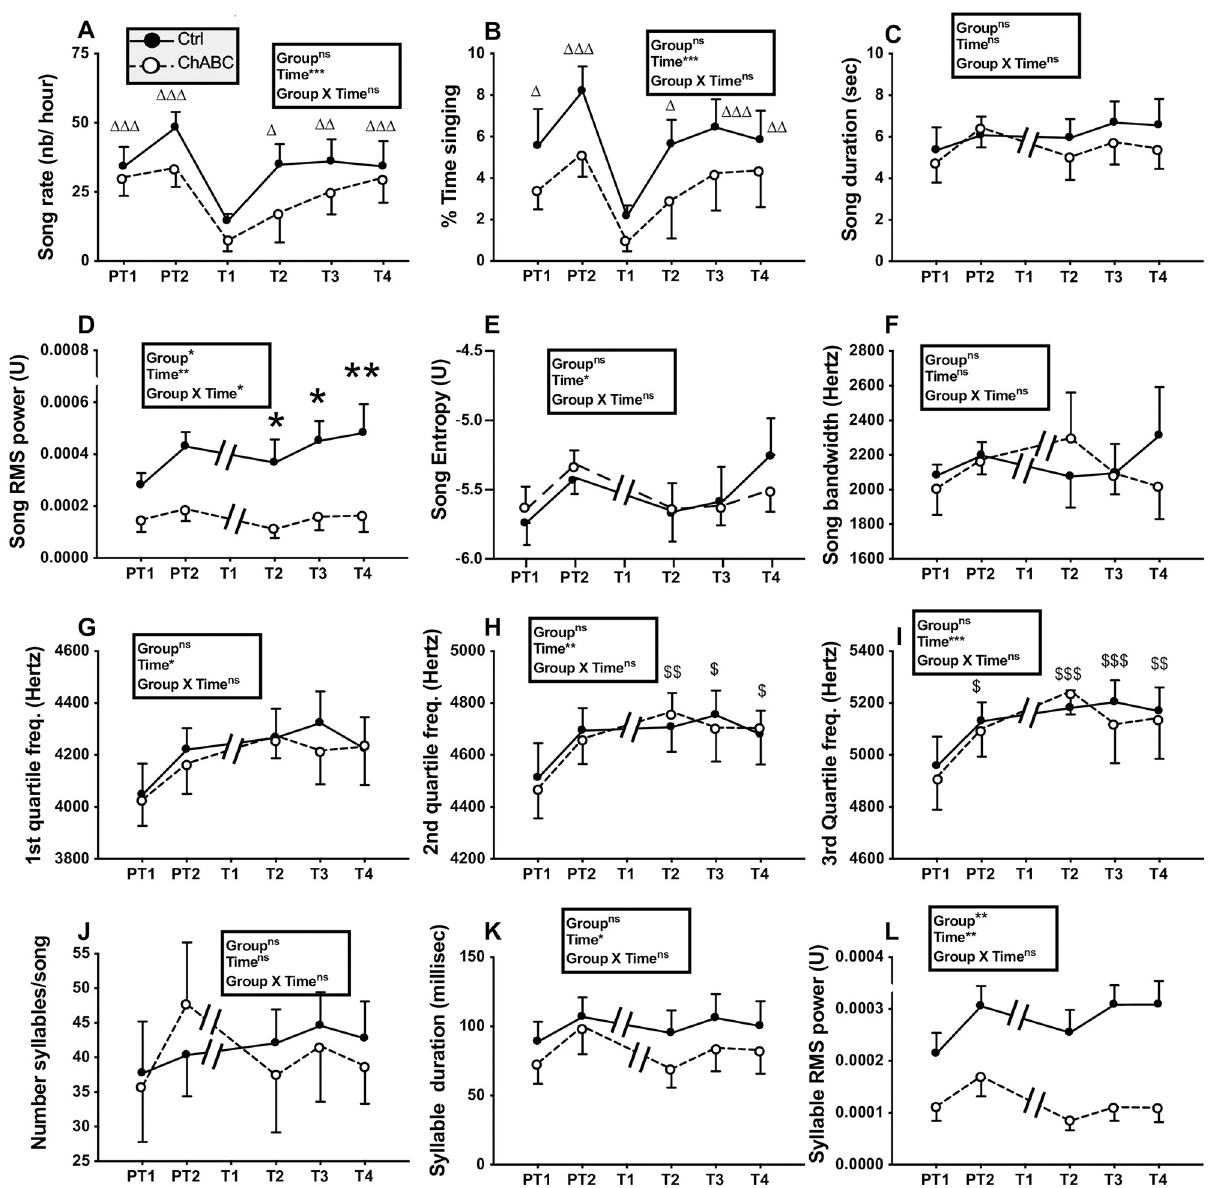
Fig 2. Song rate and song features before (pretests PT1, PT2) and the next four weeks after (tests T1 to T4) bilateral treatment of HVC with ChABC (N = 7) or the saline control (Ctrl; N = 8). The T1 time point was not analyzed for measurements of song quality because most birds did not sing during that week (see panels A and B). Data were analyzed by two-way ANOVA with treatments as independent factor and time as a repeated factor and results are summarized in the insert for each panel. Results of post-hoc analyses of significant interactions are indicated by asterisks ( � p < 0.05, �� p < 0.01 compared to the Ctrl group). Results of post-hoc analyses of significant main effects of time are indicated by triangle(s) for comparison with T1 and by dollar signs for comparison with PT1 ( Δ or $ p < 0.05, ΔΔ or $$ p < 0.01, ΔΔΔ or $$$ p <